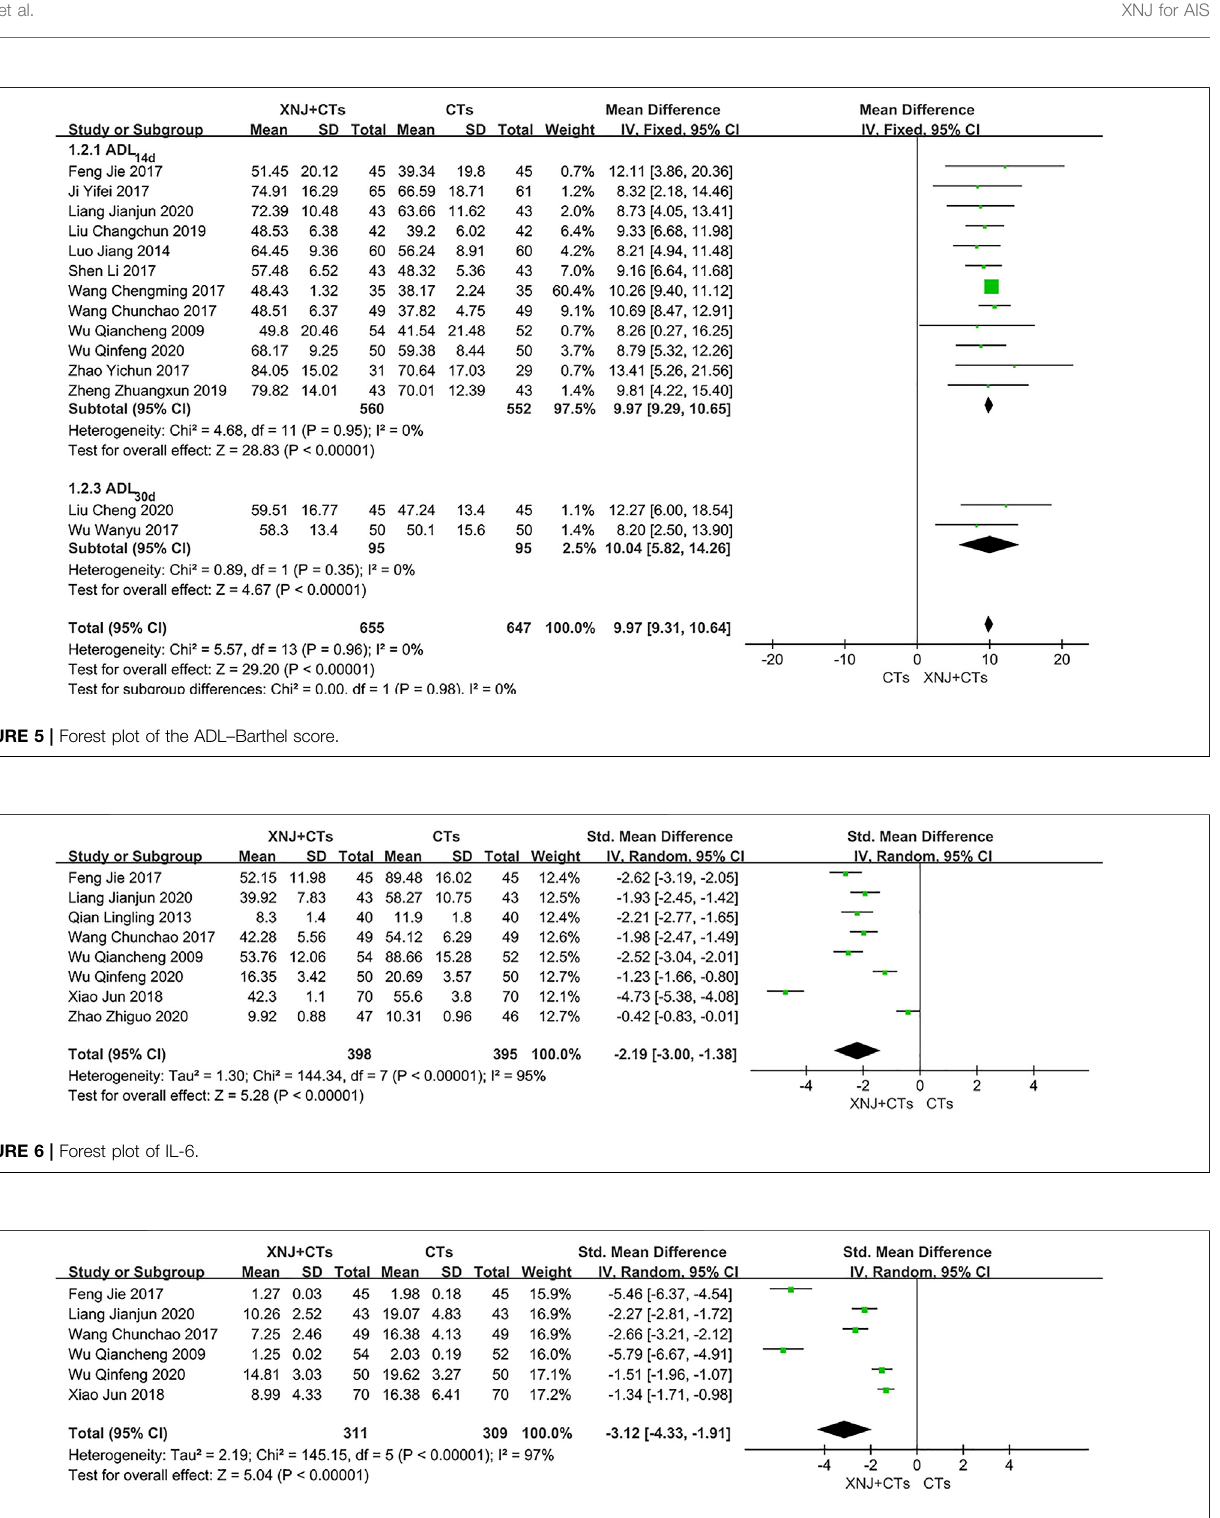
FIGURE 7 | Forest plot of TNF- α